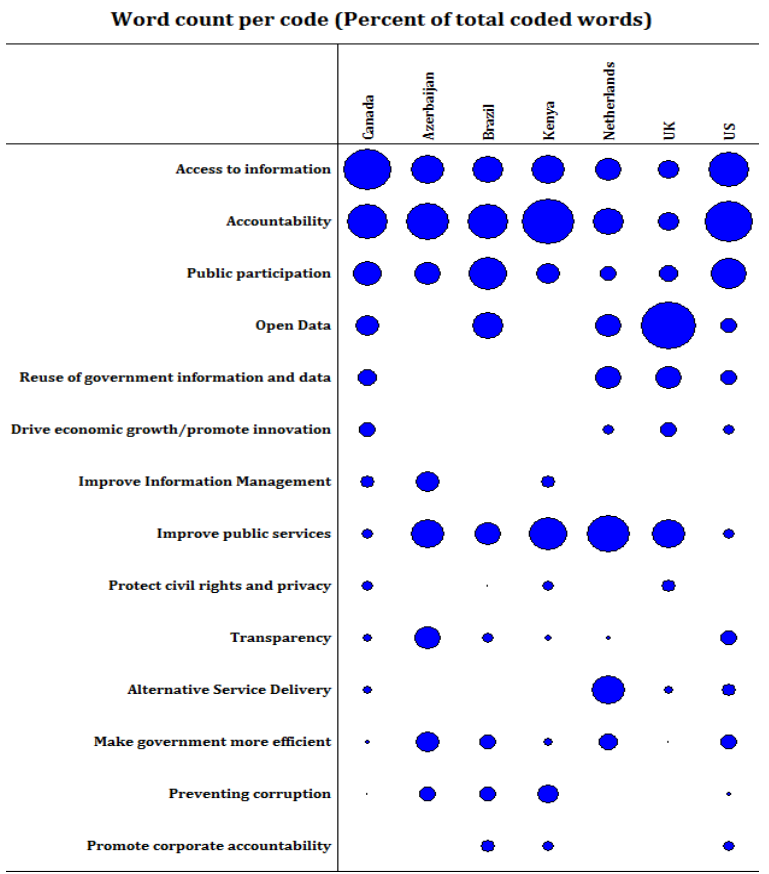
Figure 5: Salience of codes by country Action Plans (measured as per cent of total coded